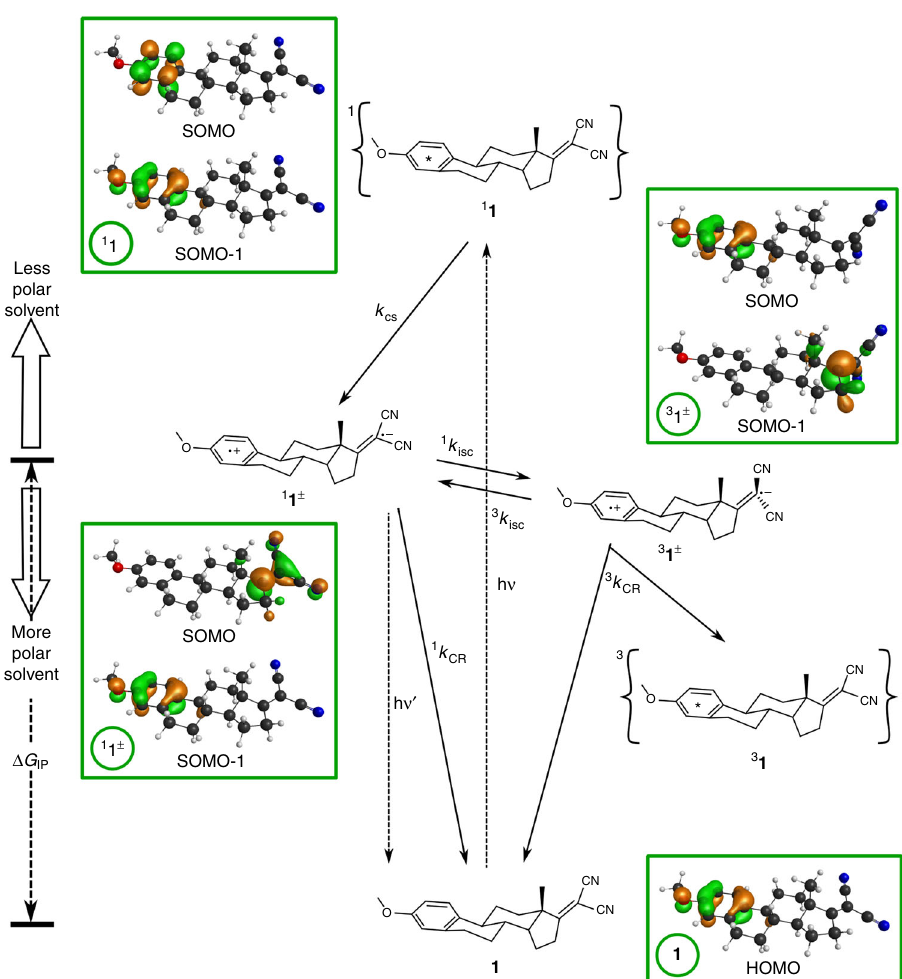
Fig. 1 Mechanism of the intramolecular electron transfer reaction. Frontier molecular orbitals of LE and CT states of 1 , and charge separation and recombination rate constants. Molecule 2 is as 1 but without the methoxy group. The vibrational relaxation from the initially populated Franck-Condon state of 1 is omitted for clarity and the fi rst step shown is the ultrafast generation of its lowest singlet state ( 1 1 ). This is followed by fast charge-separation to a longer-lived CT state ( 1 1 ± ). Charge recombination of 1 1 ± to the ground state ( 1 k CR ) may compete with intersystem crossing ( 1 k isc ) to the triplet manifold, where 3 1 ± may return to 1 1 ± ( 3 k isc ) or decay to the long-lived triplet state ( 3 1 ) by triplet charge recombination ( 3 k CR ) when 3 1 is energetically accessible ( E T < E CT ). The triplet yield of 3 1 ( Φ T ) is conveniently monitored by fl ash photolysis in view of its expected microsecond